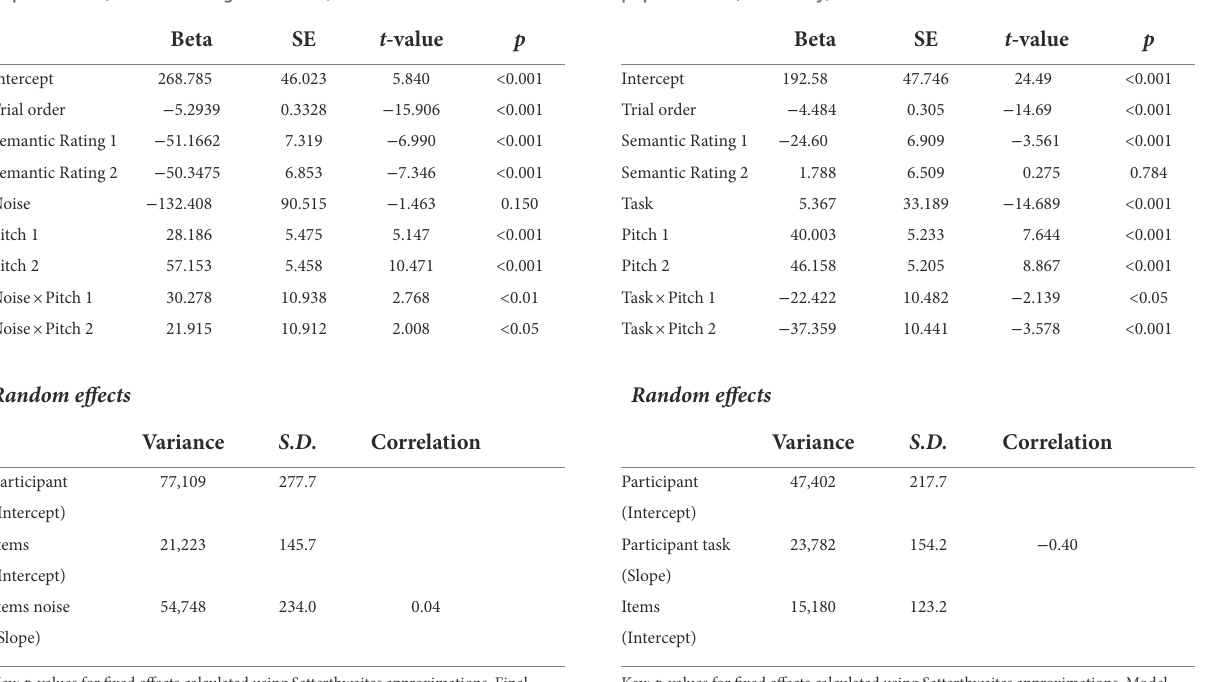
TABLE 4 Final model for the analysis of dynamic pitch/task on peak pupil dilation (Quiet only).